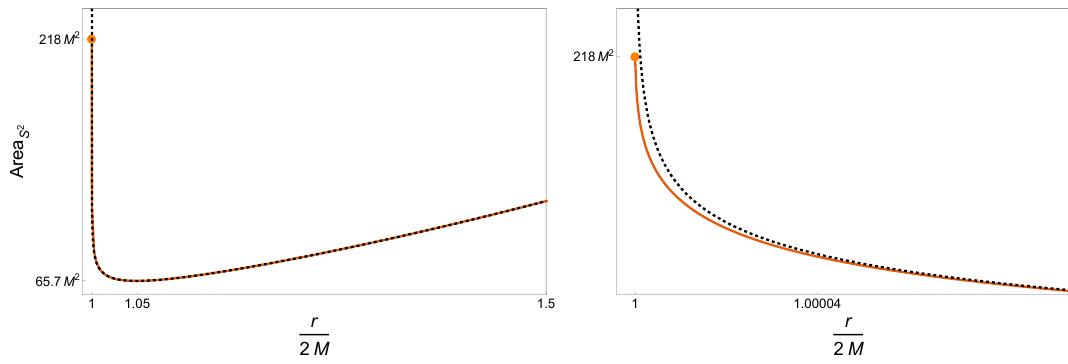
Figure 6. Area of the S 2 as a function of r/ 2 M of a neutral 41-bubble Weyl star (orange thick line) and its approximate bag spacetime away from its surface (black dashed line). At r = 2 M the area for the Weyl star is finite, Area 218 M 2 , but diverges for the bag geometry. Otherwise, the S 2 ≈ two results are indistinguishable above r > 1 . 00004 × 2 M , that is very close to the surface of the star even if N = 20 .